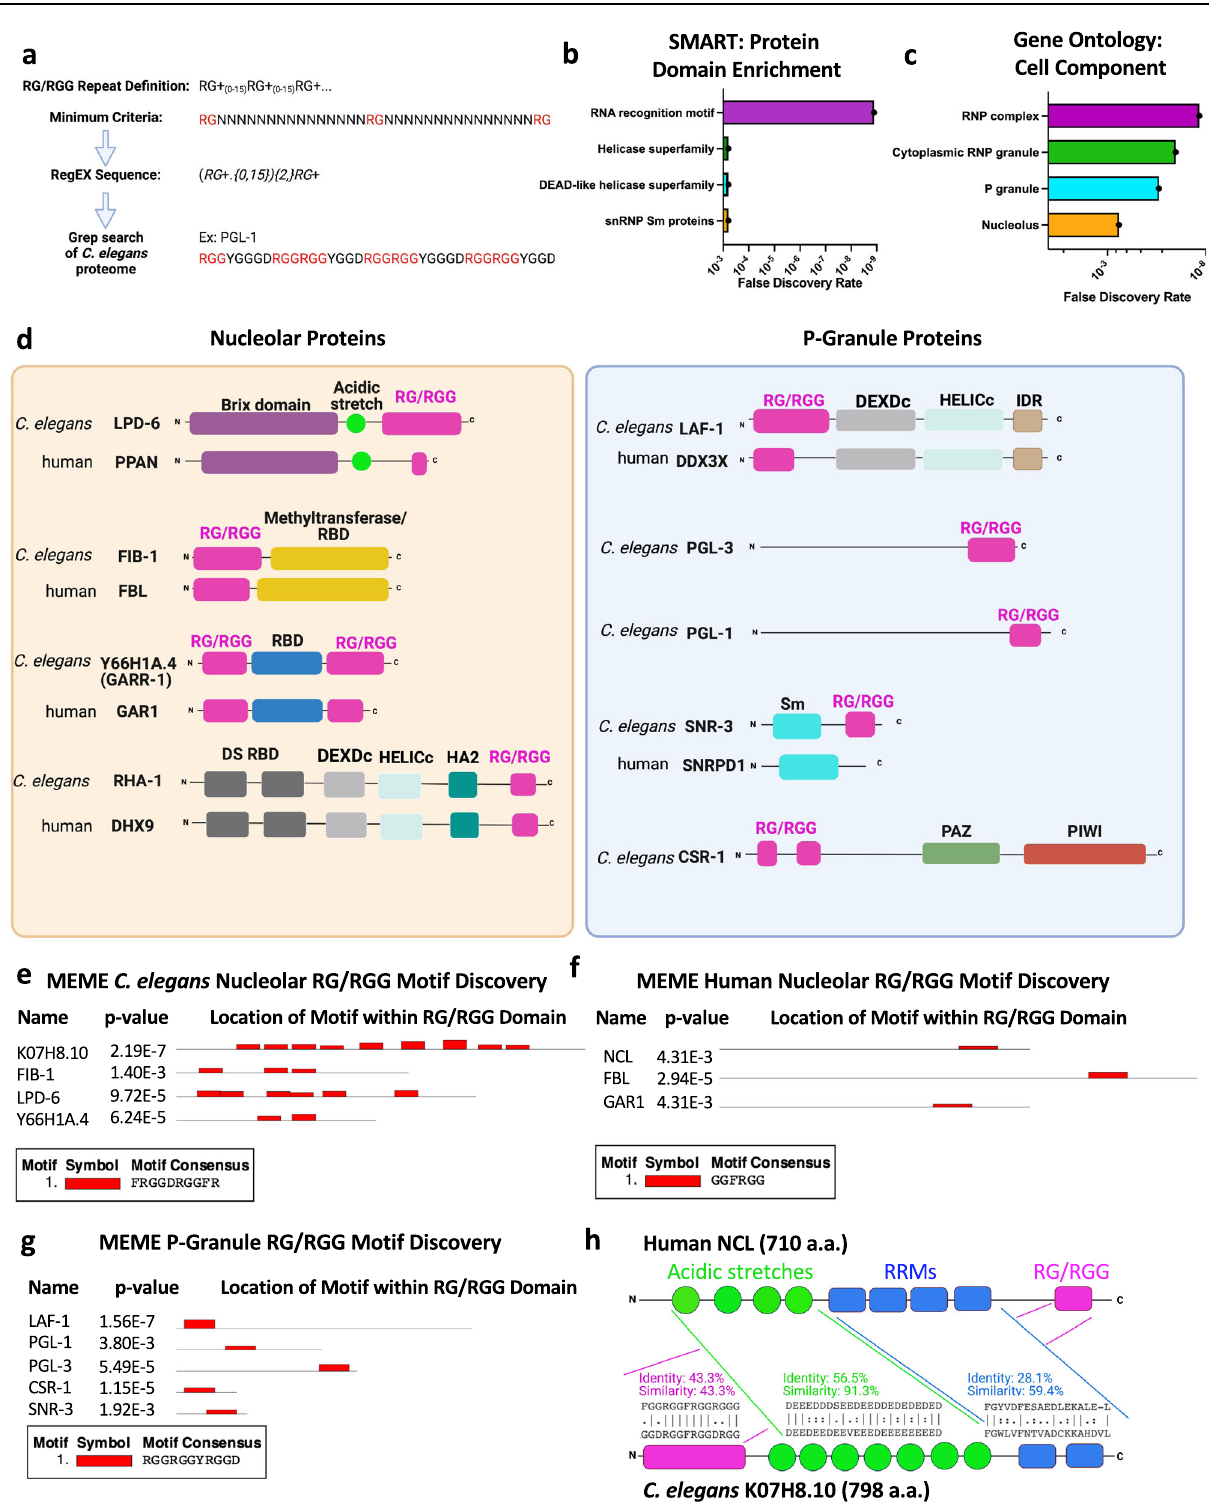
Fig. 1 | RG/RGG-repeat survey in C. elegans reveals K07H8.10 as a homolog of human Nucleolin. a Strategy for identifying regularly spaced RG/RGG repeats. b SMARTproteindomainenrichmentofthe43proteinsthatcontainthe50longest RG/RGGrepeats.The4domainswiththelowestfalsediscoveryrateareshown.The RRMisthemostenricheddomaininRG/RGG-containingproteins. c The50longest RG/RGG repeats are enriched in BMCs. d C. elegans Nucleolar and P-granule